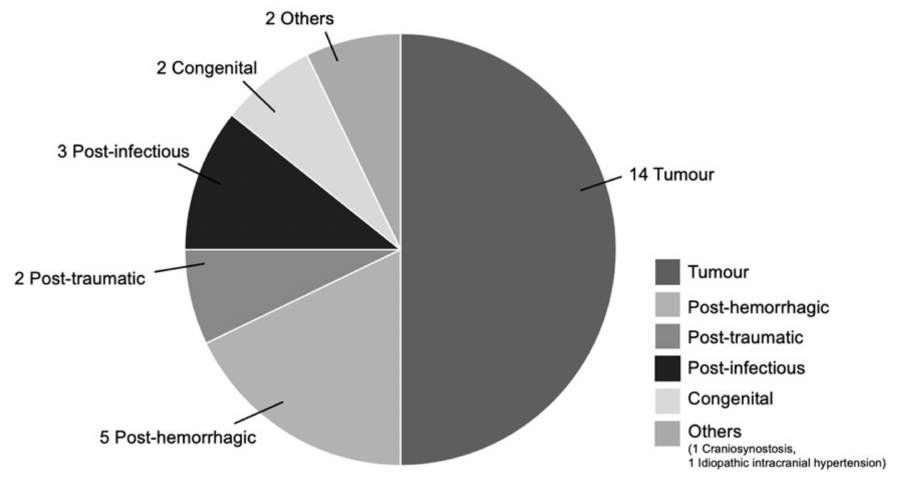
Figure 3. Indications for index PSV insertion.